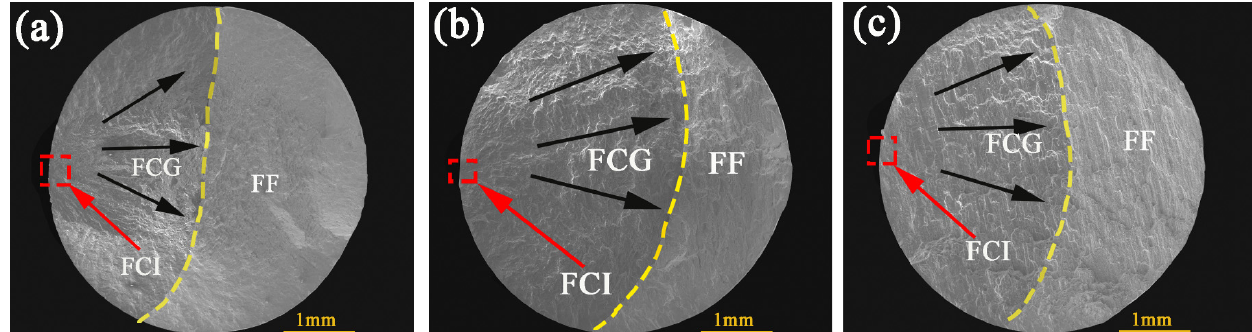
Figure 11. SEM images of fatigue fracture surfaces of the 7075 Al alloy tested at a total strain amplitude of 0.5% for ( a ) ED, ( b ) 45°, and ( c ) RD specimens.